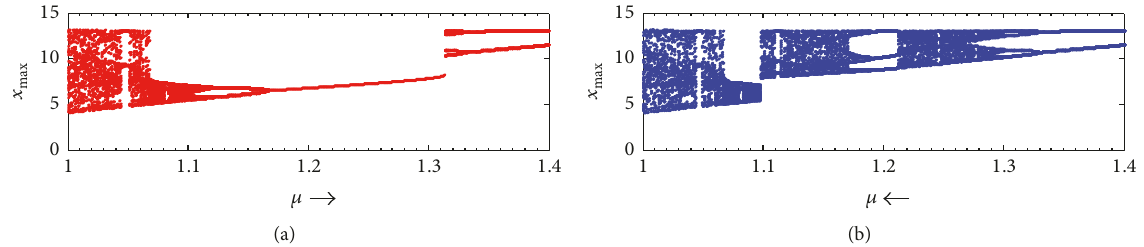
Figure 5: Enlargement of the bifurcation diagram of Figure 2 showing the region in which the system exhibits multiple coexisting attractors. This region corresponds to values of 𝜇 in the range: 1 ≤ 𝜇 ≤ 1.4 . Two sets of data corresponding, respectively, to (a) increasing (upward sweep in red) and (b) decreasing (downward sweep in blue) values of the bifurcation control parameter are